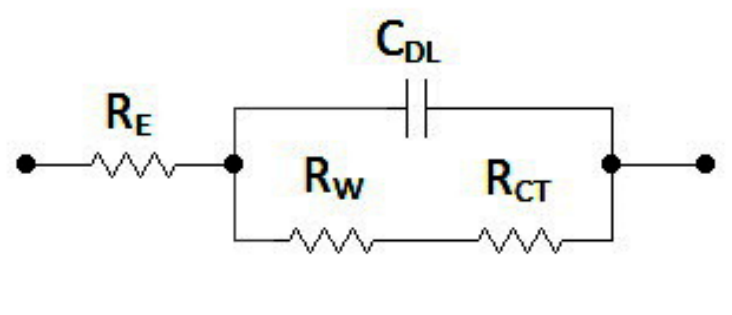
Figure 3. Battery cell